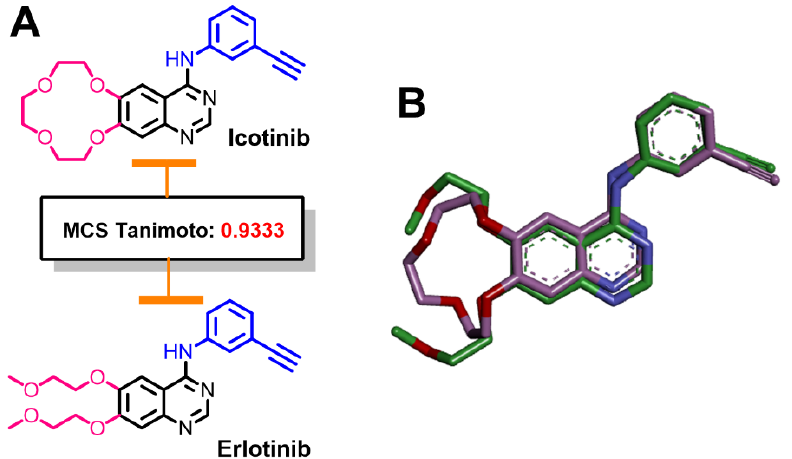
Figure 2. Structural similarity of icotinib and erlotinib: ( A ) 2D representations showing the equivalent fragments indicated by the same color; ( B ) overlay view of the two molecules (3D representa- tions).